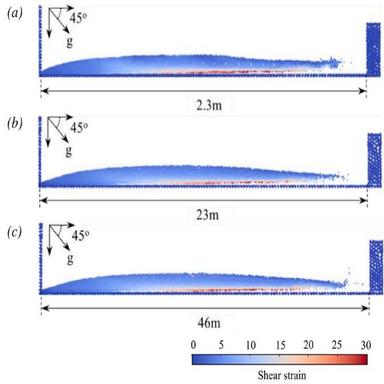
Shear strain profile across scaled models by (a) λ = 1, (b) λ = 10, (c) λ = 20.